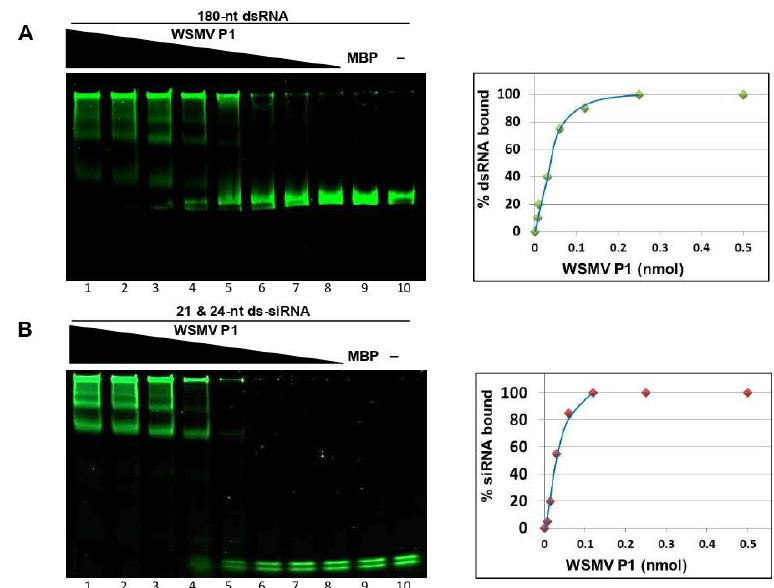
Figure 3. Dynamics of WSMV P1 and dsRNA interaction. WSMV P1 in a two-fold serial dilution starting from 0.5 nmol (lanes 1–8) or MBP (lane 9) incubated with 100 ng of 180-nt dsRNA ( A ) or 50 ng of 21- and 24-nt ds-siRNAs ( B ). RNA-only lane is represented as “ − “ (lane 10). Lower bands represent unbound dsRNA, whose intensities of fluorescence subtracted from 100% (total dsRNA loaded) were plotted against the amount of MBP::P1 loaded. RNAs incubated with serially diluted MBP::P1 or with 0.5 nmol of MBP were separated through 4–12% non-denaturing polyacrylamide gel electrophoresis, followed by SYBR Green staining. The amount of fluorescence in lower bands represent percentage of unbound RNA whose di ff erences from the amount of RNA used initially (100%) were plotted against the amount of MBP::P1 loaded in each well